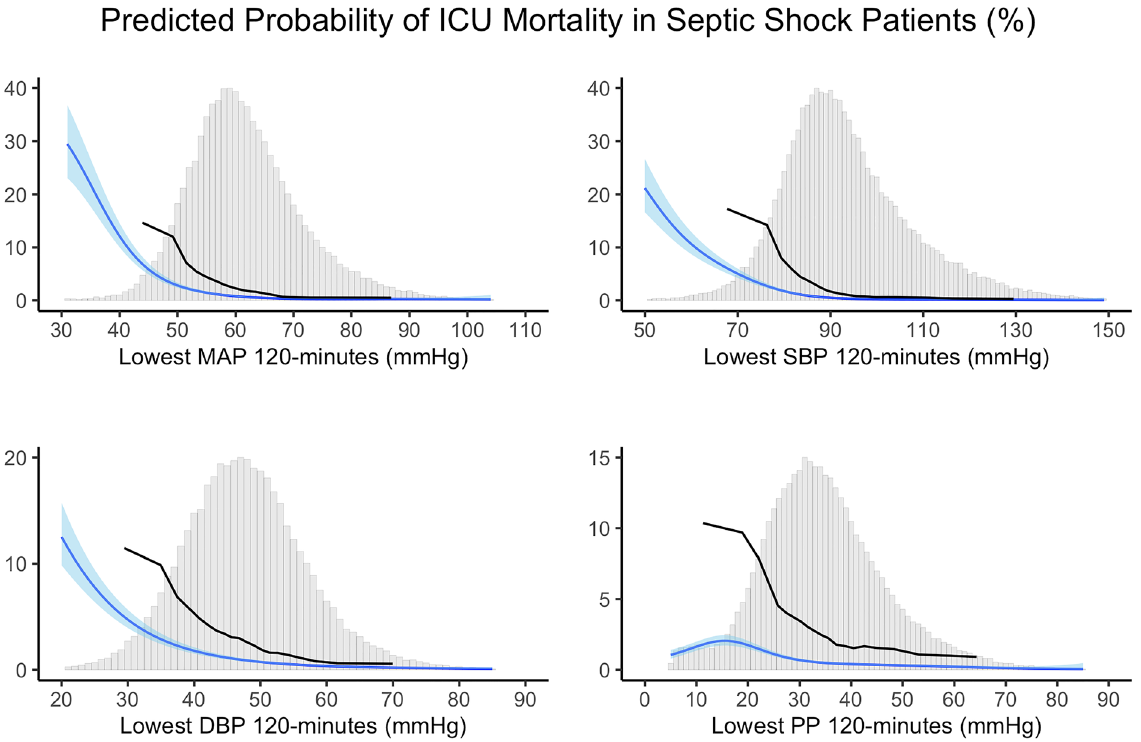
Fig. 2 Relationship between lowest blood pressure values and ICU mortality in septic shock